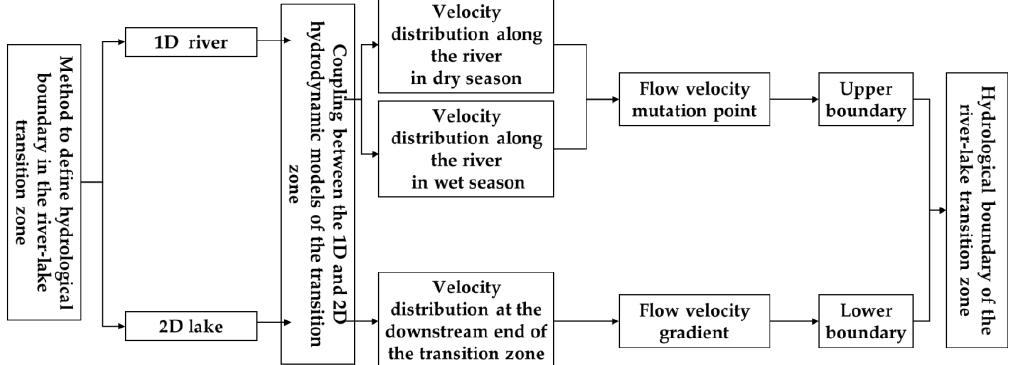
Figure 2. Process for defining the hydrological boundaries in the river–lake transition zone.